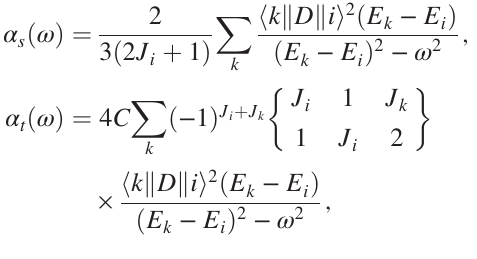
TABLE I. Contibutions to the Sr scalar α 520 and 515.2 nm in a.u. Correspoding energy differences Δ E in cm − 1 and reduced electric-dipole matrix elements D in a.u. are also